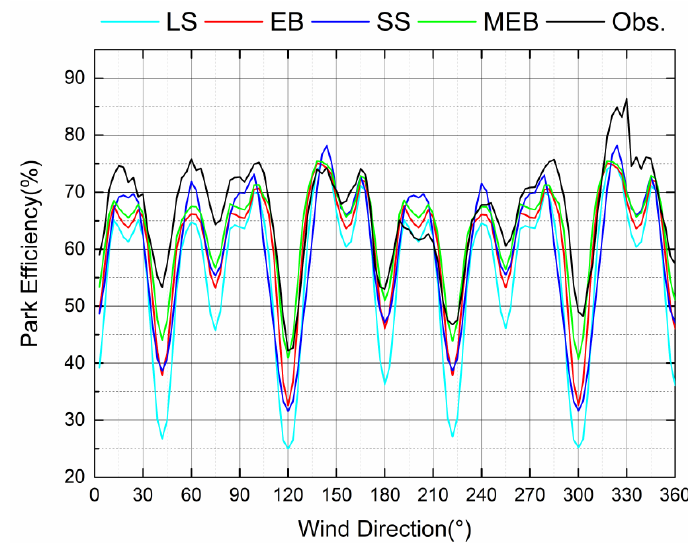
Figure 6. Park efficiency of the Lillgrund wind farm for the inflow sector 0 – 360° with 3° increments. To conduct quantitative analysis, the root mean square error (RMSE) and the mean absolute